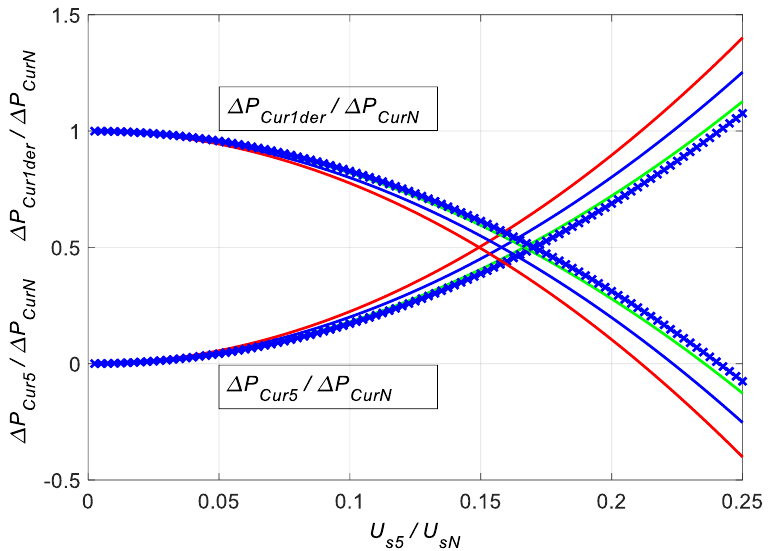
Figure 3. The sum of rotor load power losses from higher harmonics (i.e., 5th only) and admissible power losses in the rotor from the fundamental harmonic, as a function of the RMS value of the 5th harmonic of the supply voltage. Blue line — model 1, green — model 2, red — model 3, blue line with x symbol — based on Formulas (29) – (32).